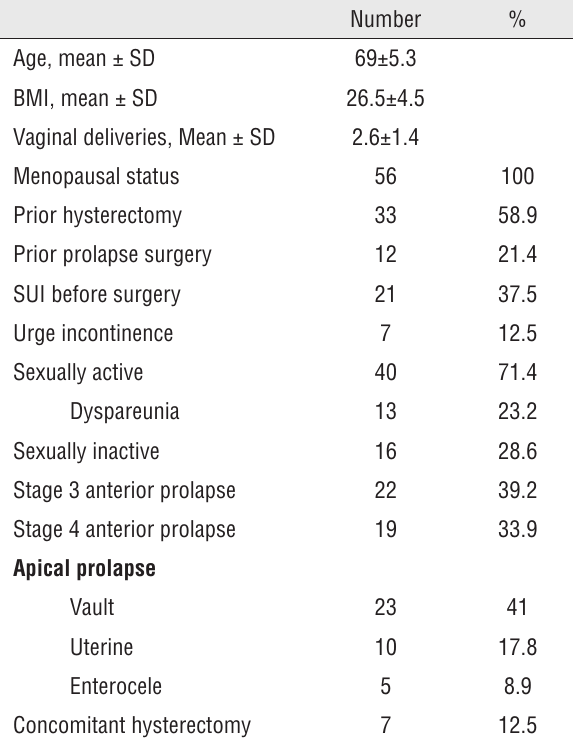
Table 1 - Baseline demographics and